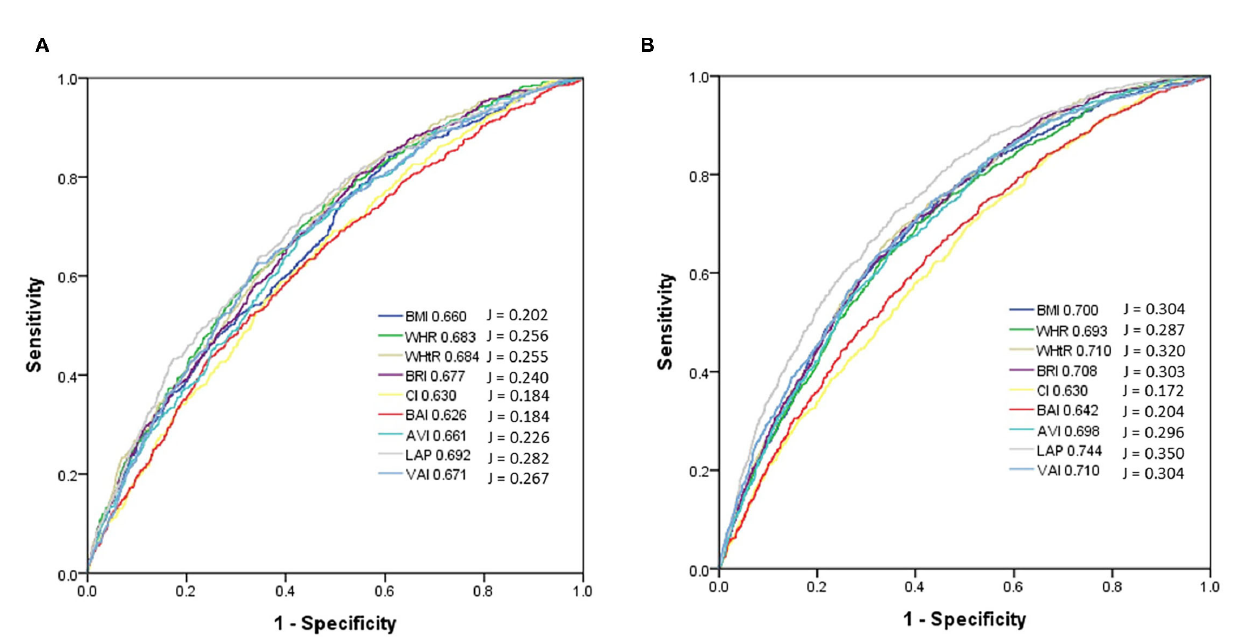
FIGURE2 Comparison of the AUC and J values of 9 obesity-related indices for diagnosis of incidence of diabetes mellitus among (A) males and (B) females. In the male participants, LAP had the highest AUC (0.692) and J (0.282), followed by WHtR (AUC = 0.684, J = 0.255), WHR (AUC = 0.683, J = 0.256), BRI (AUC = 0.677, J = 0.240), VAI (AUC = 0.671, J = 0.267), AVI (AUC = 0.661, J = 0.226), BMI (AUC = 0.660, J = 0.202), CI (AUC = 0.630, J = 0.184), and BAI (AUC = 0.626, J = 0.184). In the female participants, LAP also had the highest AUC (0.744) and J (0.350), followed by WHtR (AUC = 0.710, J = 0.320), VAI (AUC